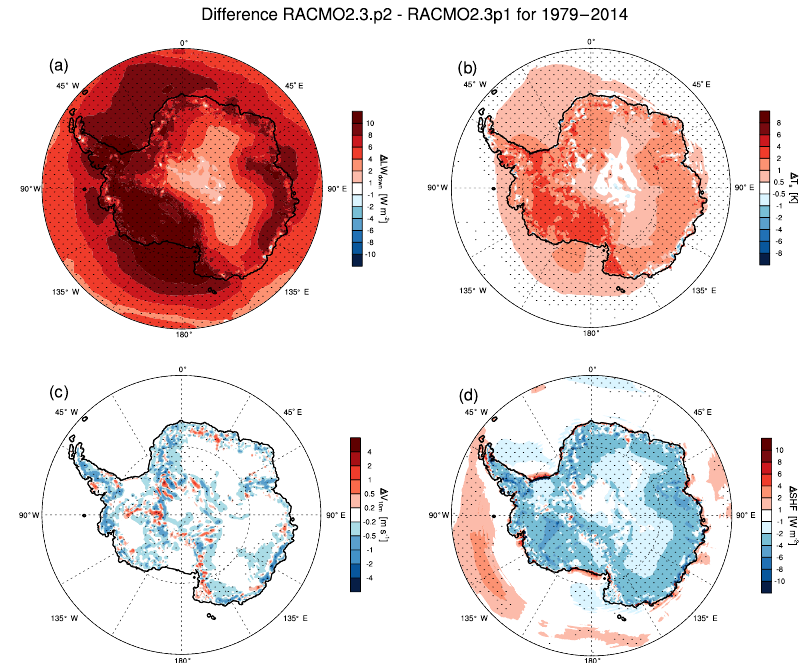
Figure 2. Annual average (1979–2014) difference (RACMO2.3p2–RACMO2.3p1) of (a) downwelling longwave radiation (LW d ), (b) surface temperature ( T s ), (c) 10m wind speed ( V 10m ) and (d) sensible heat flux (SHF). Areas where the difference exceeds 1 standard deviation of the difference are